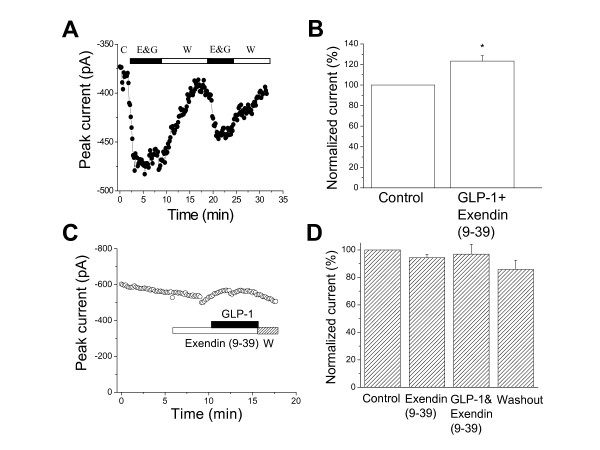
Effects of the GLP-1R inhibitor Exendin (9-39) on the GLP-1-induced enhancement of L-type Ca2+ currents in isolated canine left ventricular myocytes. A, The time course of the extracellular perfusion of Exendin (9-39, 100 nM) plus GLP-1 (5 nM) is shown. The GLP-1-induced enhancement of Ca2+ currents was not blocked by Exendin (9-39), even after washout and reperfusion of these two compounds. The currents were evoked by the depolarizing pulses from a holding potential of -40 mV to 0 mV every 10 s. C, control; E&G, Exendin (9-39) + GLP-1; W, washout. B, Compared to control, the average increase in peak ICa was statistically significant in the presence of Exendin (9-39) plus GLP-1 (n = 6, p < 0.05). Panel C shows the time course of ICa for control, the extracellular perfusion of 100 nM Exendin (9-39) alone (Exendin (9-39)) and Exendin (9-39) plus 5 nM GLP-1 (GLP-1), and washout (W). The currents were evoked by the pulses depolarizing from holding potential of -40 mV to 0 mV every 10 s. D, The averaged data show that 100 nM Exendin (9-39) applied 5 min ahead of GLP-1 (5 nM) perfusion abolished the GLP-1-induced enhancement of ICa (n = 5, p > 0.05).